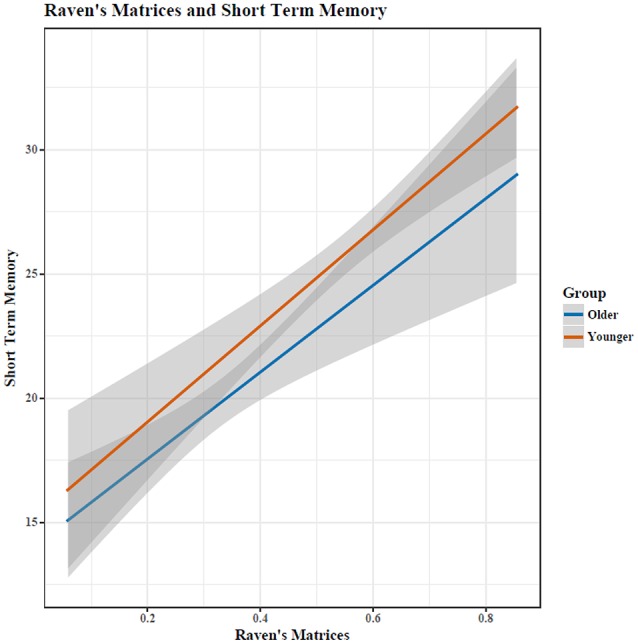
Performance on RM and STM was highly correlated (r = 0.6). Shaded area indicates 95% confidence intervals.